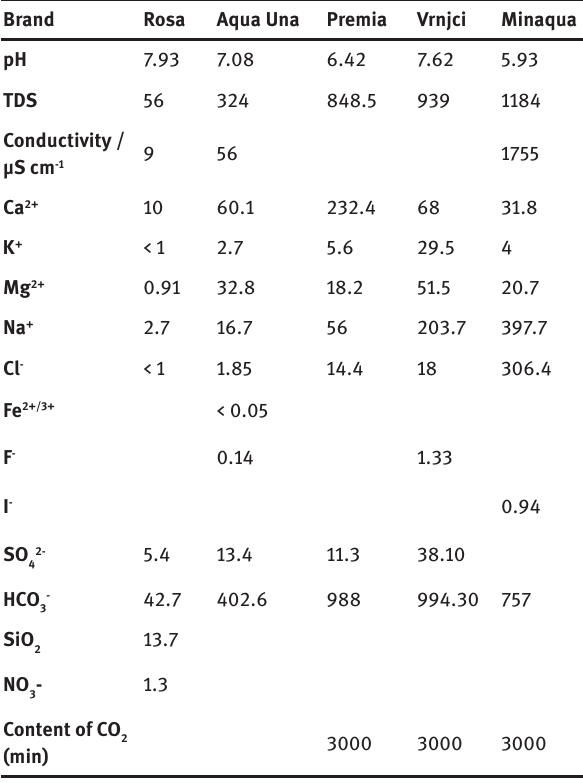
Table 1 : Chemical parameters of 5 brands of bottled mineral water samples (mg L -1